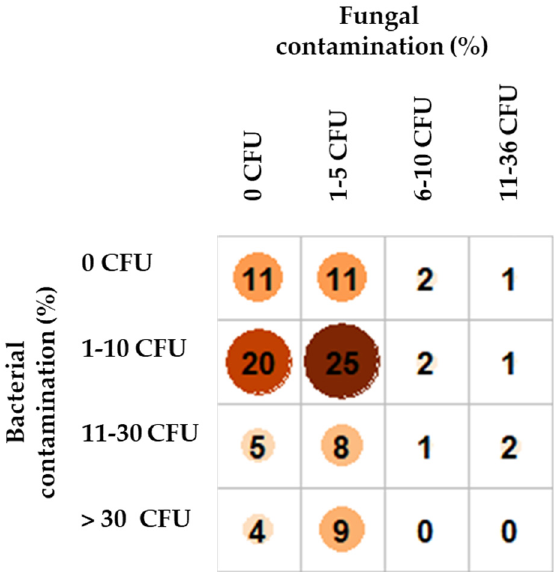
Figure 4. The frequency of single levels of bacterial and fungal contamination in tested samples.